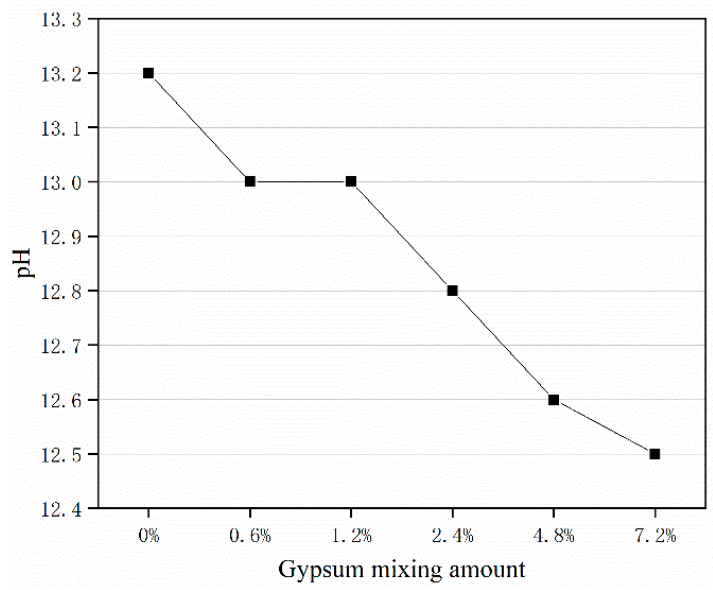
Figure 20. Effect of gypsum dosing on pH value.